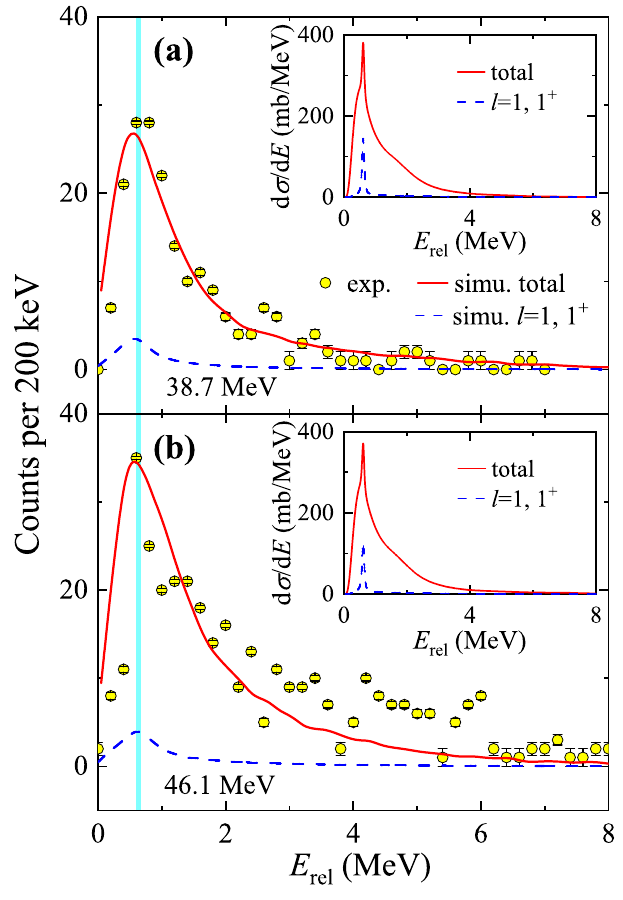
Fig. 3 | Measured E rel distributions for breakup fragments 7 Be and proton. The experimental data (circles) at a 38.7 and b 46.1MeV are compared with the simu- lated distributions of E rel (solid curves). The error bars show the associated statis- tical uncertainties. The dashed curves denote simulation results of p -wave 1 + state. Therawtheoretical E rel distributionsfromCDCCareshownintheinsets,wherethe solid and dashed curves represent the calculations with the orbital angular momentum up to l =3 (total) and the contributions from the p -wave ( l =1) 1 + state. The vertical line indicates the expected location of the peak from the fi rst 1 + reso- nance of 8